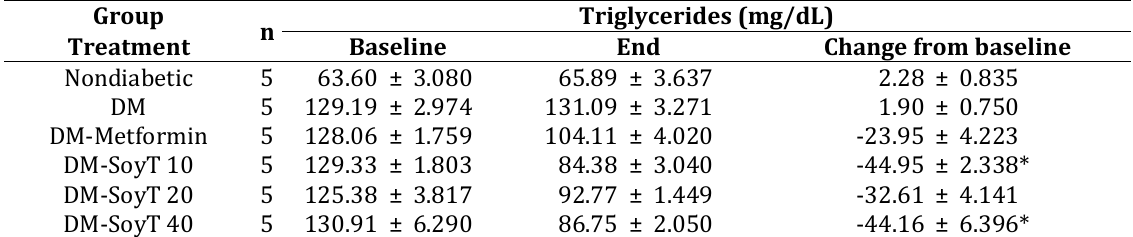
Table IV. Triglyceride levels after 3 weeks of treatment Group